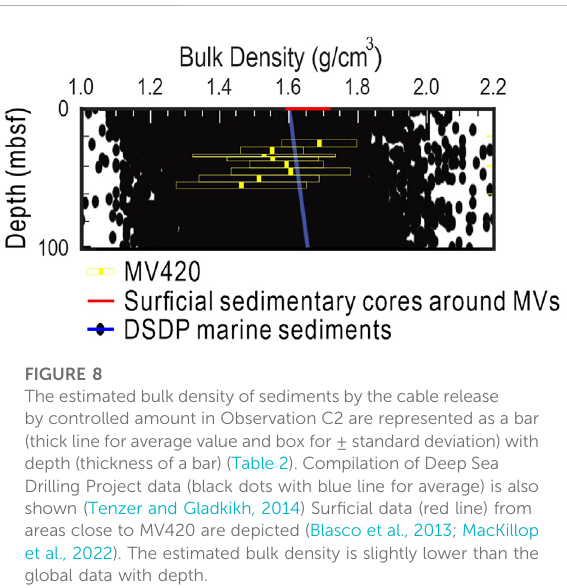
FIGURE 8 The estimated bulk density of sediments by the cable release by controlled amount in Observation C2 are represented as a bar (thick line for average value and box for ± standard deviation) with depth (thickness of a bar) (Table 2). Compilation of Deep Sea Drilling Project data (black dots with blue line for average) is also shown (Tenzer and Gladkikh, 2014) Sur fi cial data (red line) from areas close to MV420 are depicted (Blasco et al., 2013; MacKillop et al., 2022). The estimated bulk density is slightly lower than the global data with